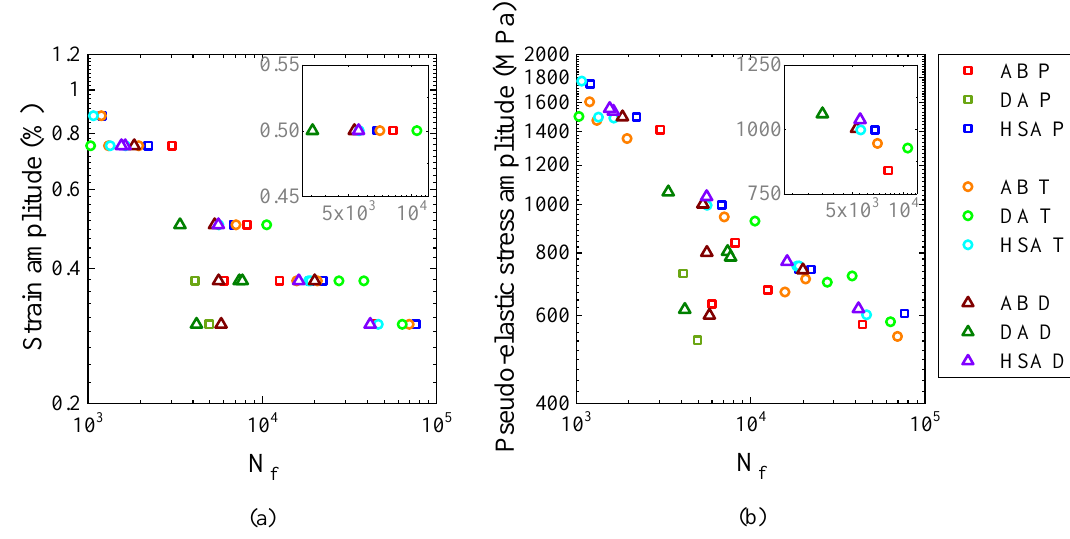
Figure 16. ( a ) Strain vs. life plots ( b ) Pseudo-elastic stress vs. life